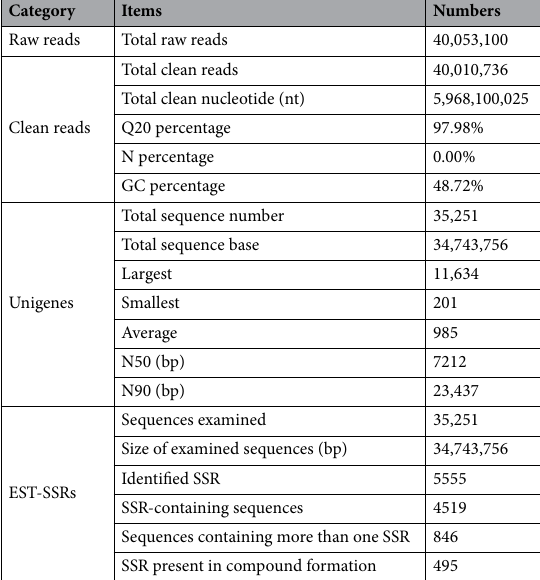
Table 1. De novo assembled EST-SSRs for S.